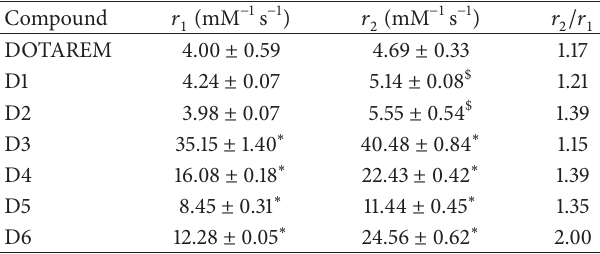
Table 1: Relaxivities 𝑟 1 and 𝑟 2 per Gd 3+ of different dendrons.